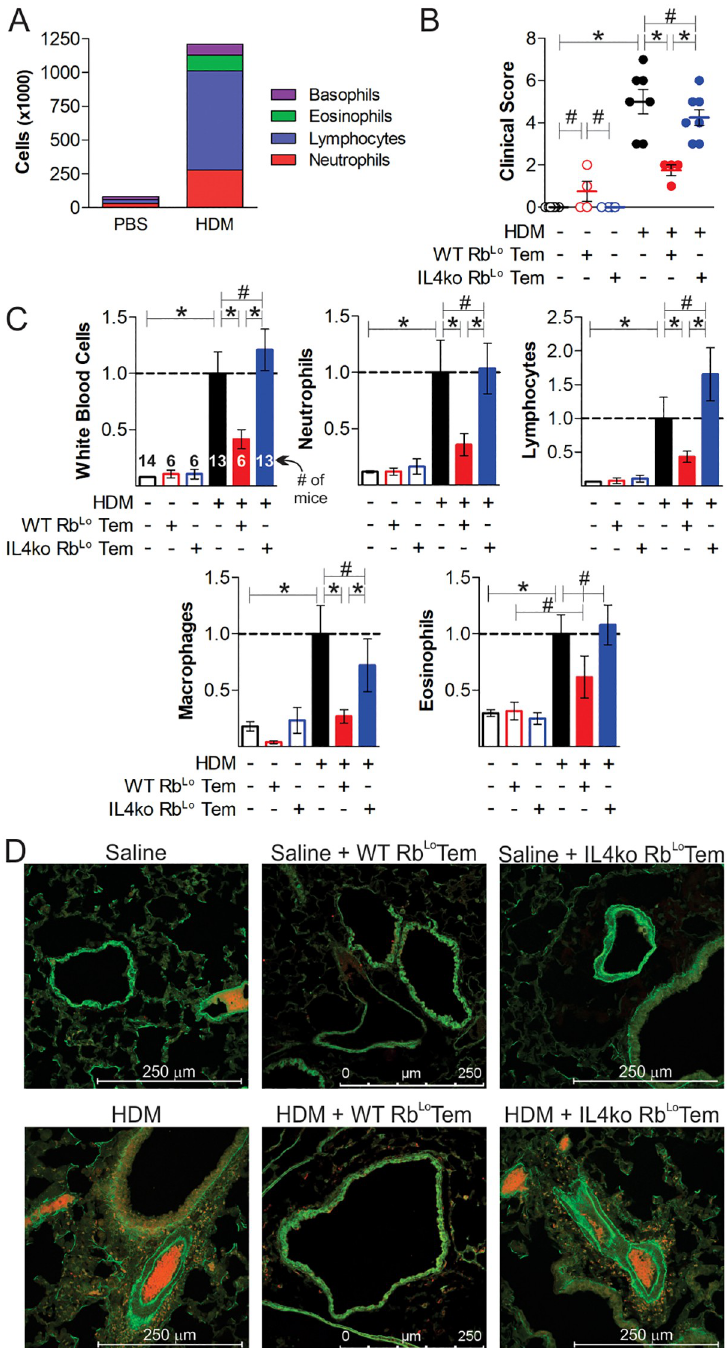
Fig 6. Rb Lo Tem cells reverse lung inflammation in an IL-4-dependent fashion. Mice were given 60,000 of anti- CD3 ε -stimulated WT or IL-4ko Rb Lo Tem cells on day 7 of acute HDM-induced asthma to test their ability to reverse inflammatory pathology. The total number of infiltrating cells (A), the clinical score (see Table 1) (B), normalized cellular differentials from BALf harvests (C), and tissue pathology (D) by immunofluorescence staining for EpCAM (green) and MPO (red) from representative sections of pulmonary tissue are shown. � = p < 0.05; # = p > 0.05. P value calculated from an unpaired Student’s T-Test. Error bars show mean with SEM. n = 6 to 14 individual mice total per group, across two asthma trials, as indicated on the White Blood Cell counts in panel